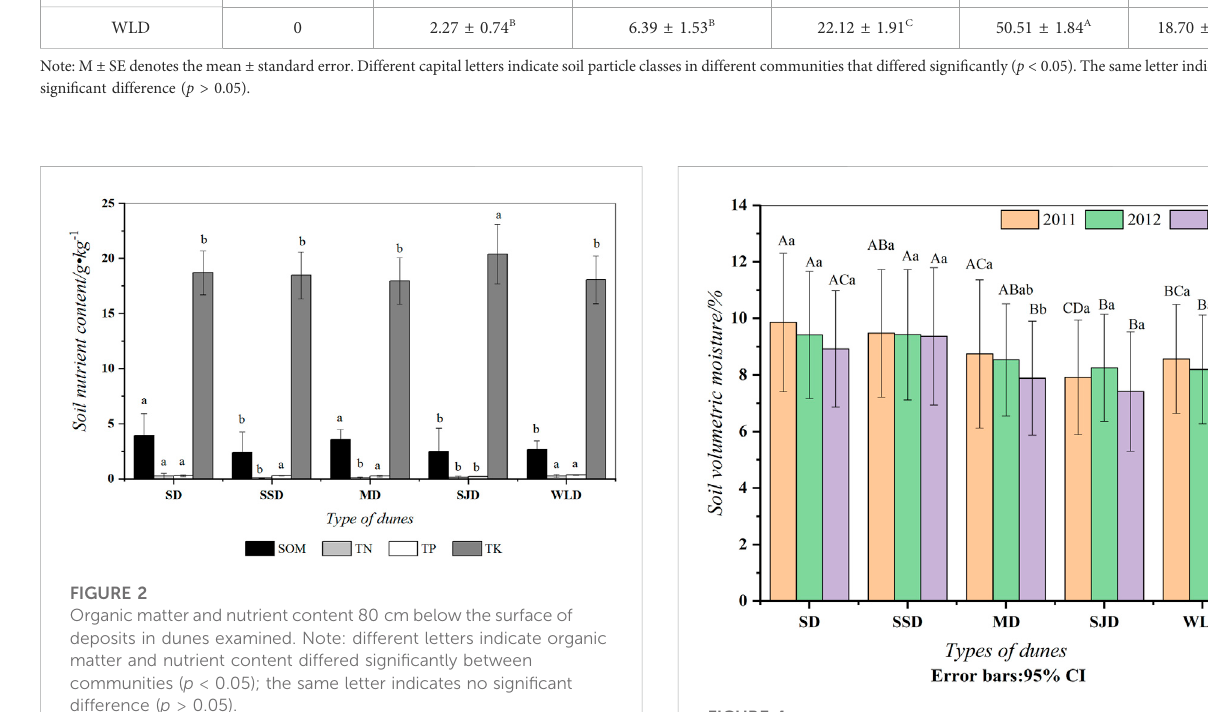
FIGURE 4 Soil moisture dynamics from 2011 to 2013 in dunes examined. Note: different capital letters indicate the SWC differed signi fi cantly betweencommunities( p < 0.05),whiledifferentsmalllettersmeanthe SWC of the same communities varied signi fi cantly from year to year ( p < 0.05). The same letter indicates no signi fi cant difference ( p >